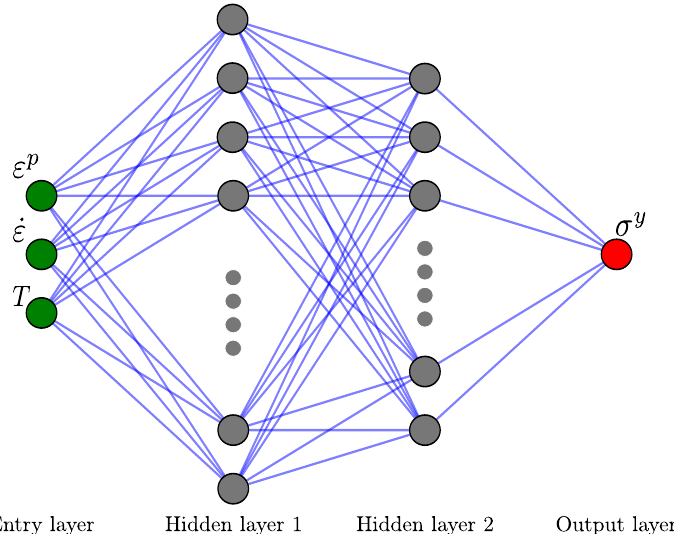
Figure 11. Two hidden layers artificial neural network architecture with 3 inputs neurons (green) and 1 output neuron